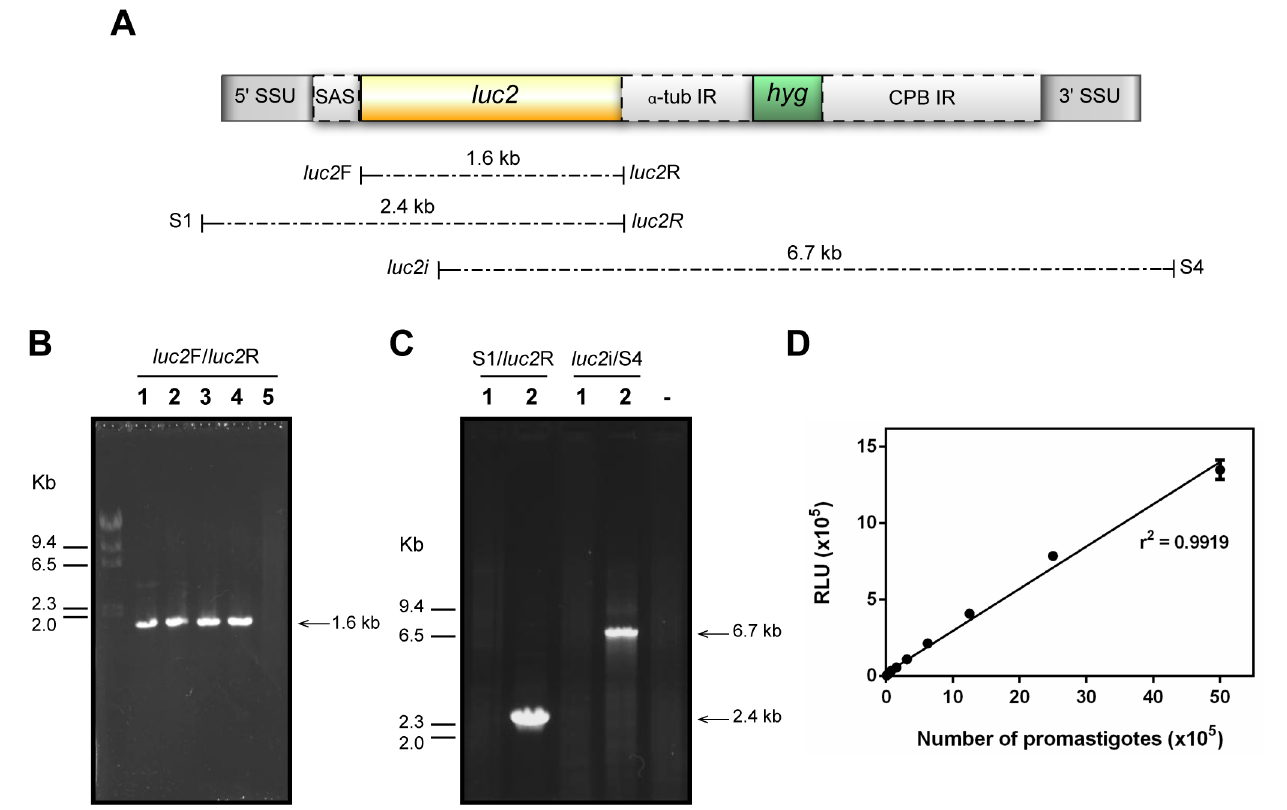
Fig 1. Characterisation of a transgenic line of L . braziliensis expressing luciferase. (A) Schematic representation of the linear cassette for integration in the SSU rDNA locus . SSU, small subunit; SAS, splice acceptor site; luc2 , luc2 coding sequence; α -tub IR, intergenic region of the L . enrietii α -tubulin gene; hyg , hygromycin phosphotransferase gene; CPB IR, L . mexicana cysteine protease B gene intergenic region. Position of the primers and size of amplified fragments are indicated by the dotted lines. (B) Size separation of PCR products amplified using primers complementary to the luc2 ORF extremities from genomic DNA purified from four independent transfected clones (lanes 1 to 4) and from the wild type strain (lane 5). (C) Agarose gel electrophoresis of amplified products obtained from Lb -WT (lane 1) or Lb -LUC (lane 2) with the pairs of primers S1/luc2 R or luc2 i /S4. (-) indicates the control reaction without template DNA. (D) Luminescence intensity and number of Lb -LUC promastigotes. Promastigotes were serially diluted and luminescence was measured using a microplate reader, after addition of luciferin. RLU, relative light units.